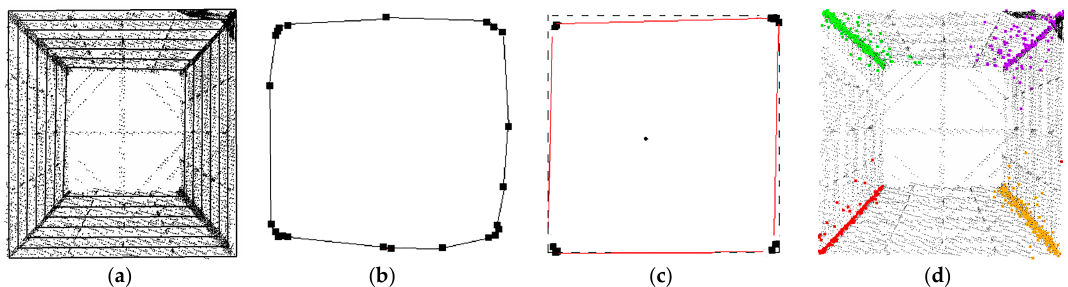
Figure 4. Extraction and segmentation of corner points: ( a ) layering results of the original pylon body point cloud; ( b ) contour points of one bin extracted by convex hull algorithm ( c ) simplified corner points; and ( d ) segmentation results of four subsets which are colored in different color.